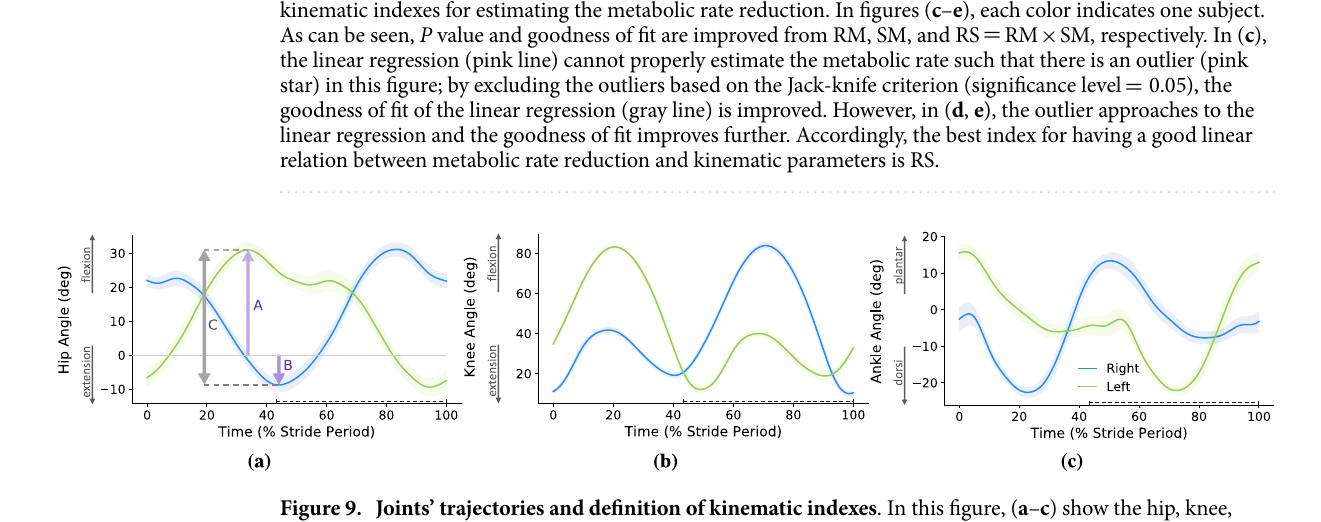
Figure 9. Joints’ trajectories and definition of kinematic indexes . In this figure, ( a – c ) show the hip, knee, and ankle joints’ trajectories, respectively. The start of the gait cycle is at the heel-strike instant of the right leg, and the swing phase is shown with a dashed line over the horizontal axes. Figure ( a ) shows the hip joint trajectory and the definition of kinematic indexes. In figure ( a ), A is the maximum angle of the left hip joint, B is the minimum angle of the right hip joint, and C is the absolute value of the difference between A and B . It is important to note that A and B are vectors and can be either positive or negative, and C is a distance, and it is always positive. As discussed “A kinematic index for metabolic rate reduction” section, the kinematic indexes are defined as range of motion (RM) = C = | A − B | , symmetry of motion (SM) = | A + B | − 1 , and RS = RM × SM = C × | A + B | − 1 ; | x | means the absolute value of x